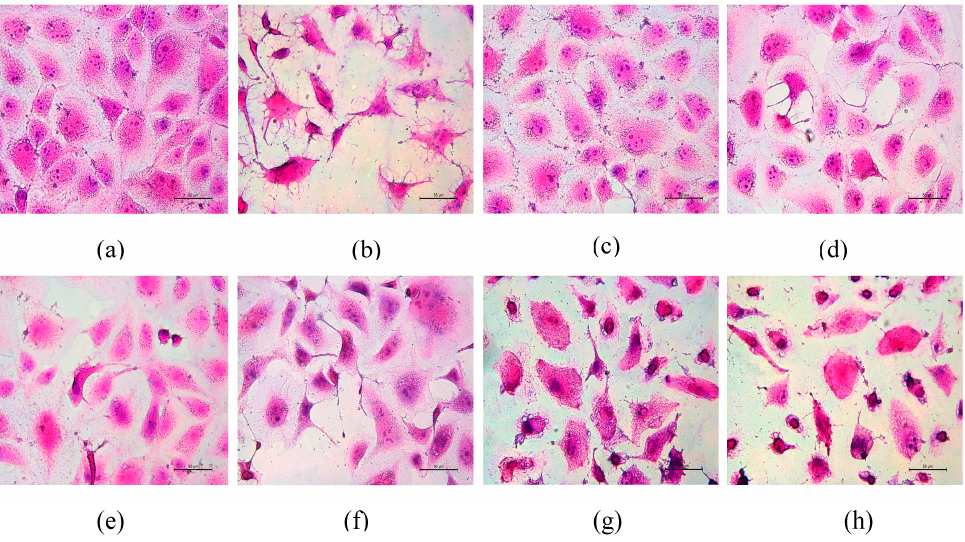
Figure 7. Repair effect of six SPSs on the morphology of damaged HK-2 cells evaluated by hematoxylin and eosin (HE) staining: ( a ) normal control; ( b ) damaged HK-2 cells; ( c ) Laminaria -1; ( d ) degraded Porphyra -2; ( e ) degraded Gracilaria -3; ( f ) degraded Sargassum -4; ( g ) Eucheuma -5; and ( h ) degraded Undaria -6. Oxalate-induced damaged HK-2 cells were treated with 60 μ g/mL polysaccharides for 8 h, and then cell morphology was determined by HE staining under a microscope. The nucleus was stained blue or purple, and the cytoplasm was pink or red. Magnification: